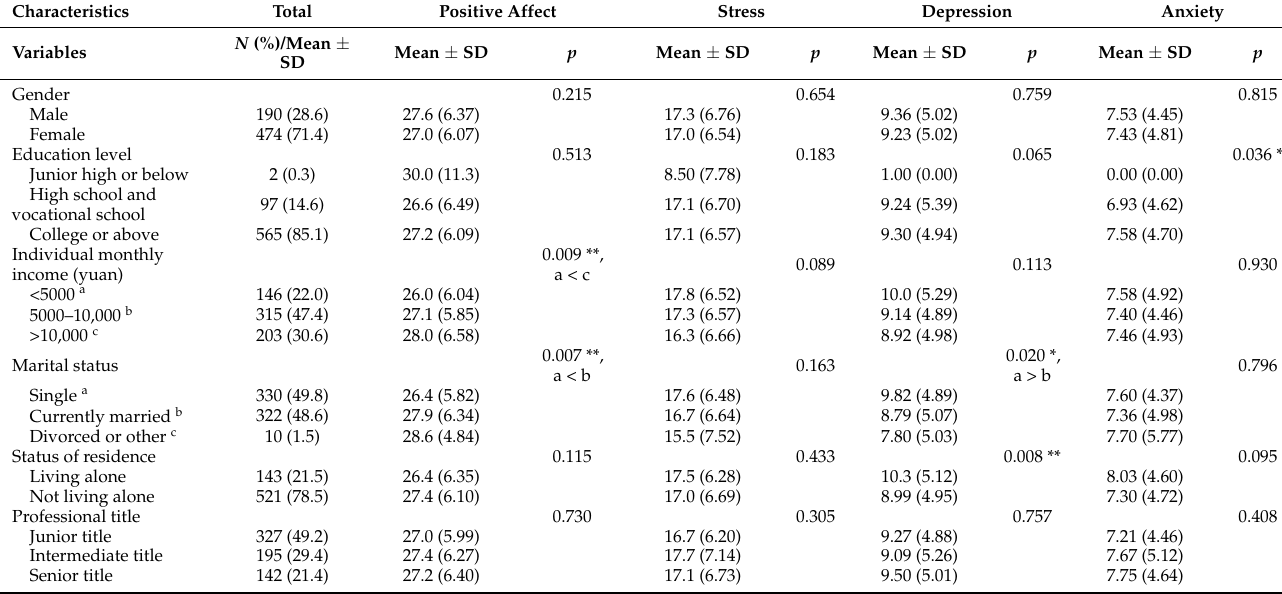
Table 1. Descriptive relationships of sociodemographic factors with stress, positive affect, depression, and anxiety ( N =